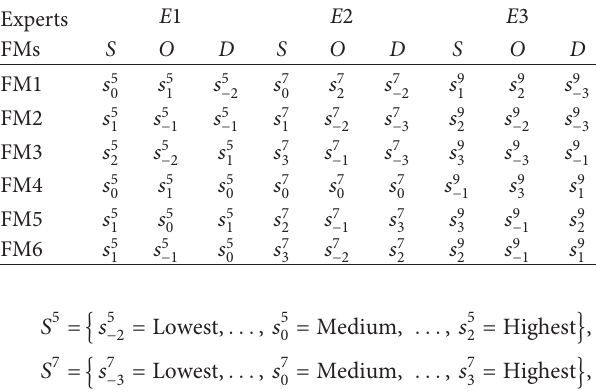
Table 2: Statistical table of the experts’ evaluation information.